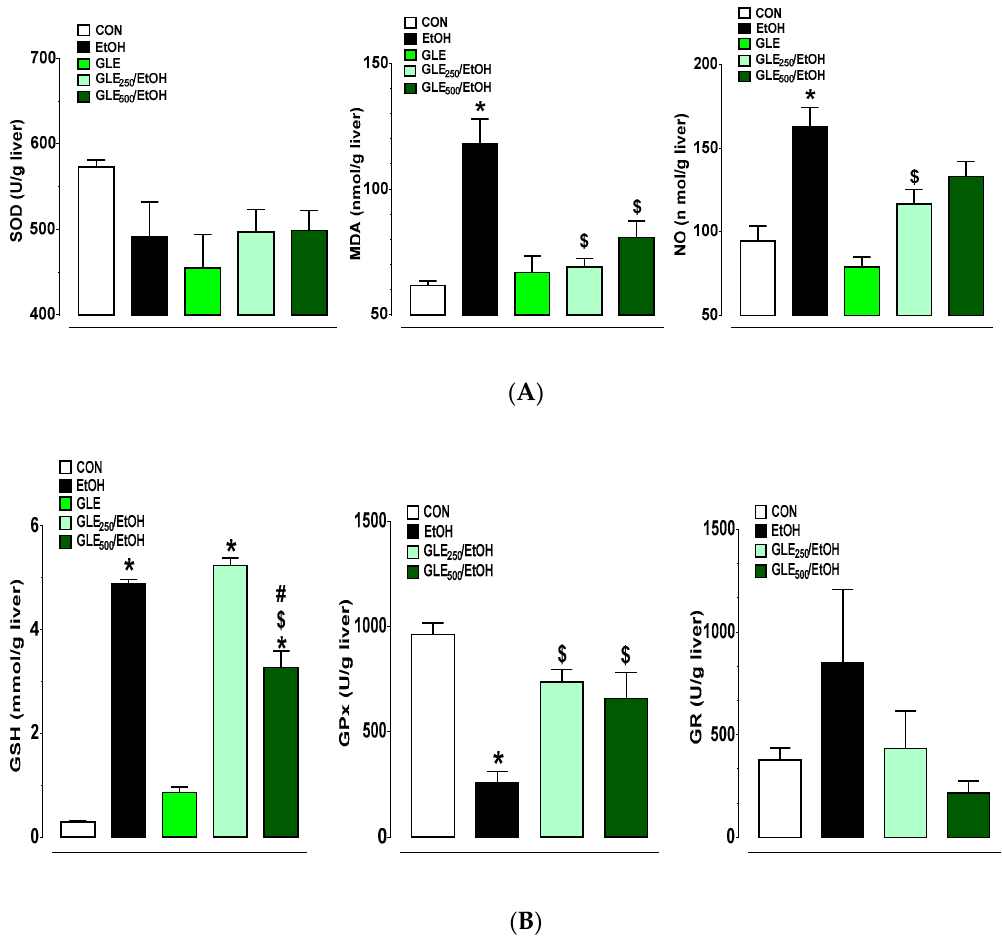
Figure 4. GLE effects on markers of oxidative stress in EtOH-treated rats. Bar graphs show changes in SOD (left panel), MDA (middle panel) and NO metabolites (right panel) ( A ) and GSH (left panel), GPx (middle panel) and GR (right panel) ( B ). Data expressed as mean ± SEM (n = 5–8), *,$,# p ≤ 0.05 compared with CON, EtOH, GLE 250 /EtOH group, respectively. Statistical analysis performed using one-way ANOVA followed by Tukey’s multiple-comparison test. CON: control, EtOH: ethanol, GLE: